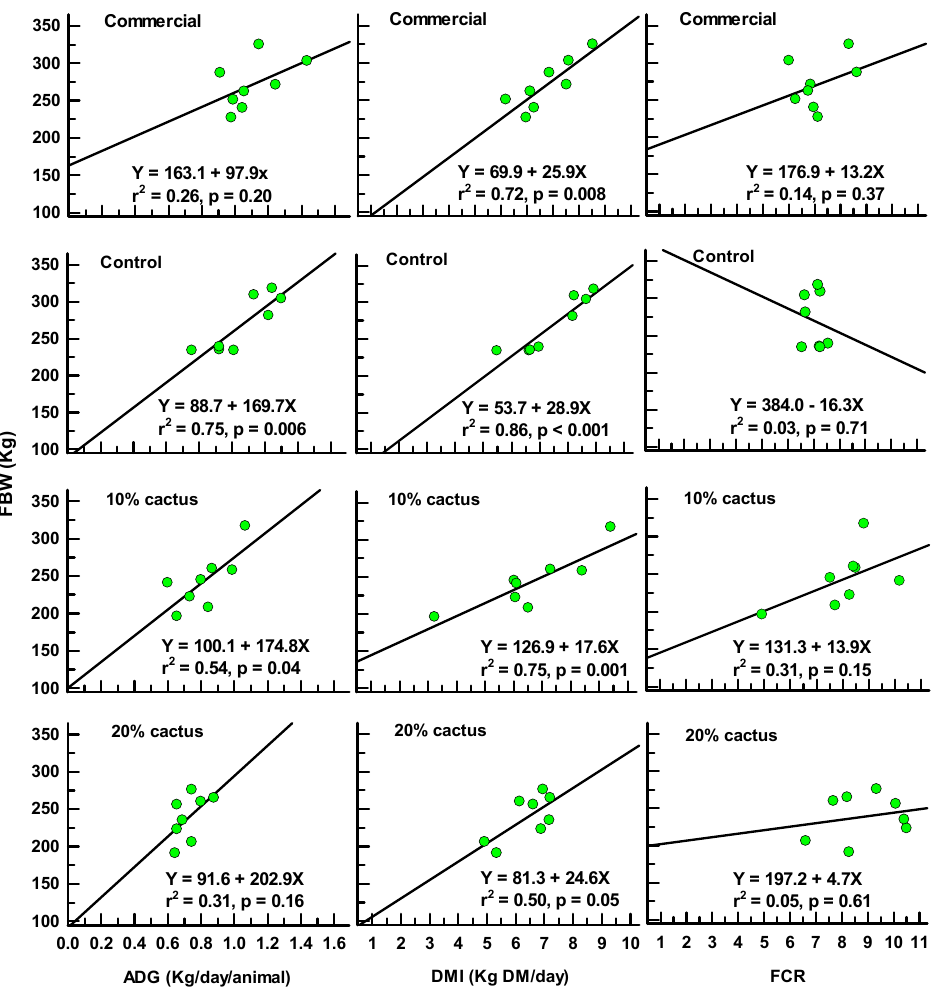
Figure 1. The relationships between final body weight (FBW) and average daily gain (ADG), dry matter intake (DMI) and feed conversion ratio (FCR) of heifers fed cactus, commercial and control diets.